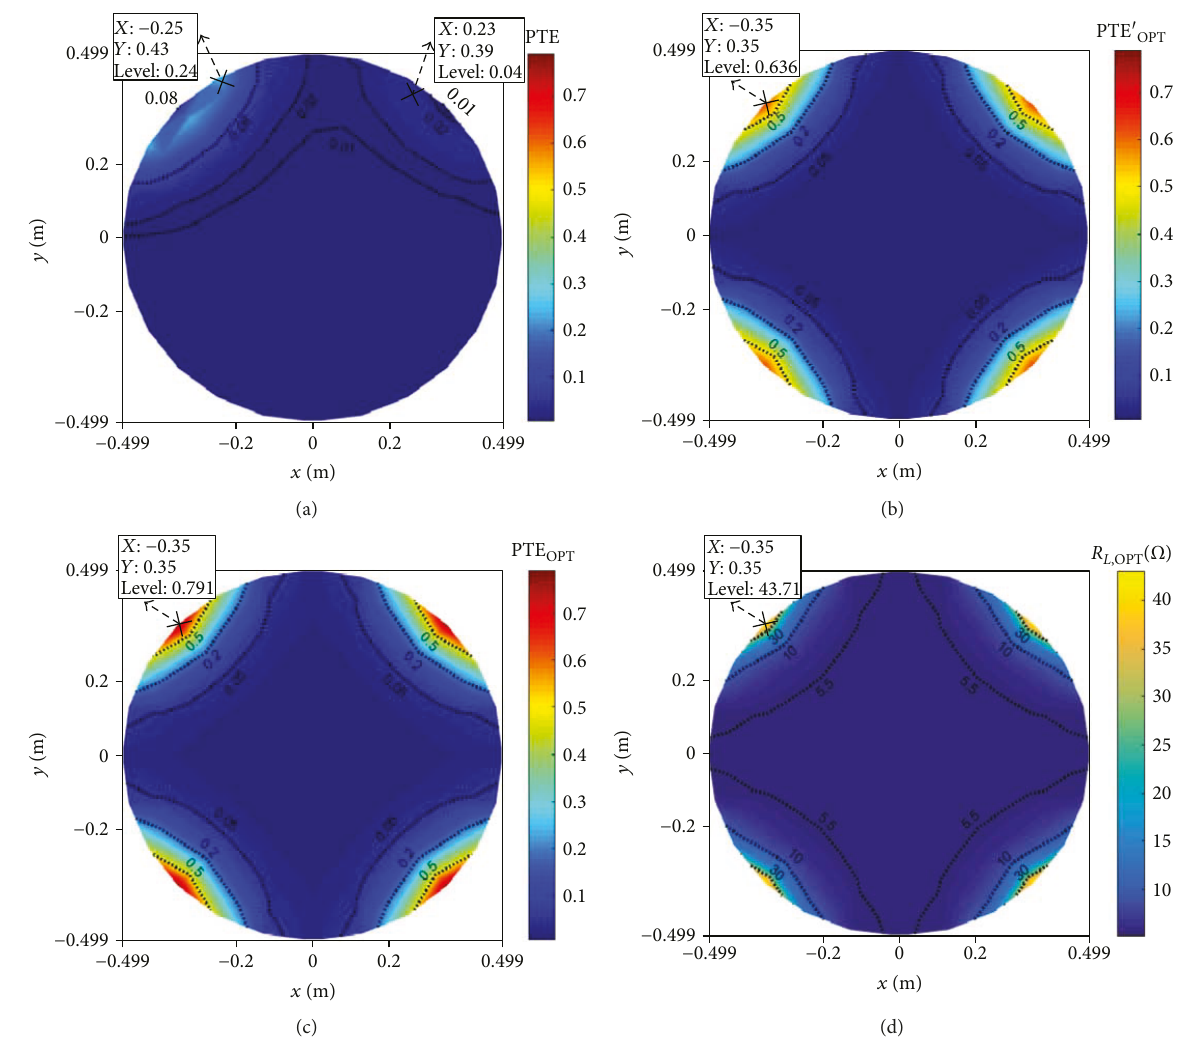
Figure 6: Calculated values of a four-TX system when RX is moving in the study area. E ffi ciency distribution in the study area (a) without optimization, (b) under conditions of V 1 V 2 V 3 V 4 = M 1 R M 2 R M 3 R M 4 R and R L = 10 Ω , and (c) under conditions of V 1 V 2 V 3 V = M M M M R = R 4 1 R 2 R 3 R 4 R and L L ,OPT . (d) Optimal load for